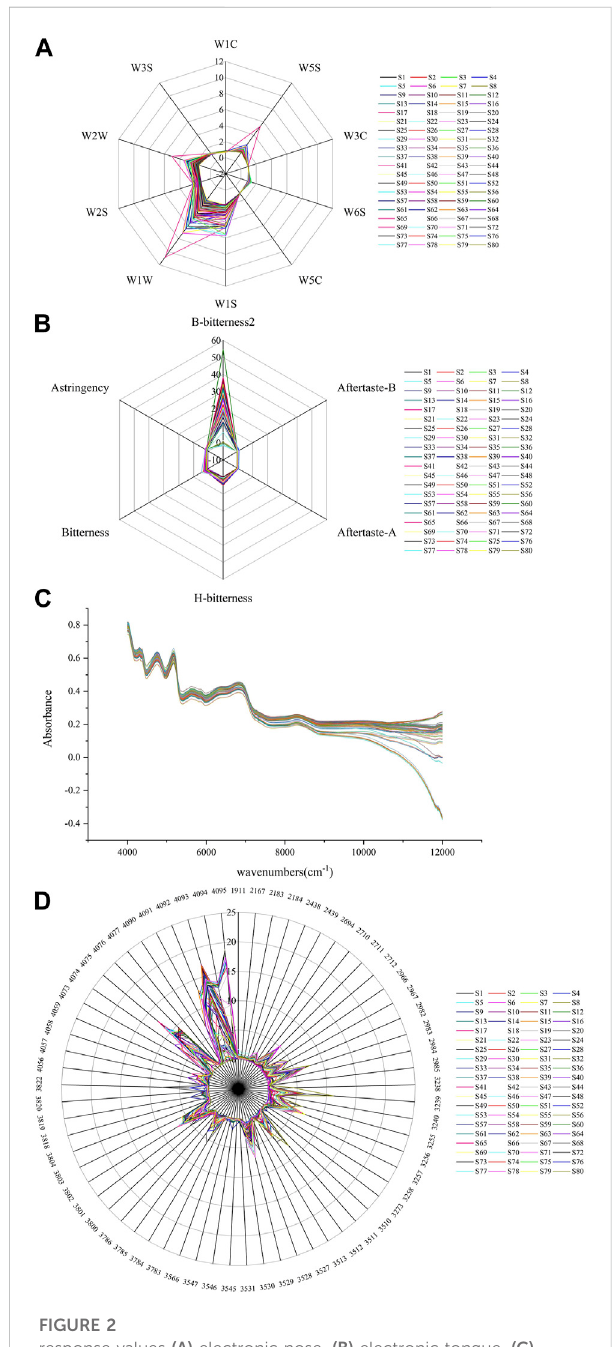
FIGURE 2 response values (A) electronic nose, (B) electronic tongue, (C) NIR spectra, (D) electronic